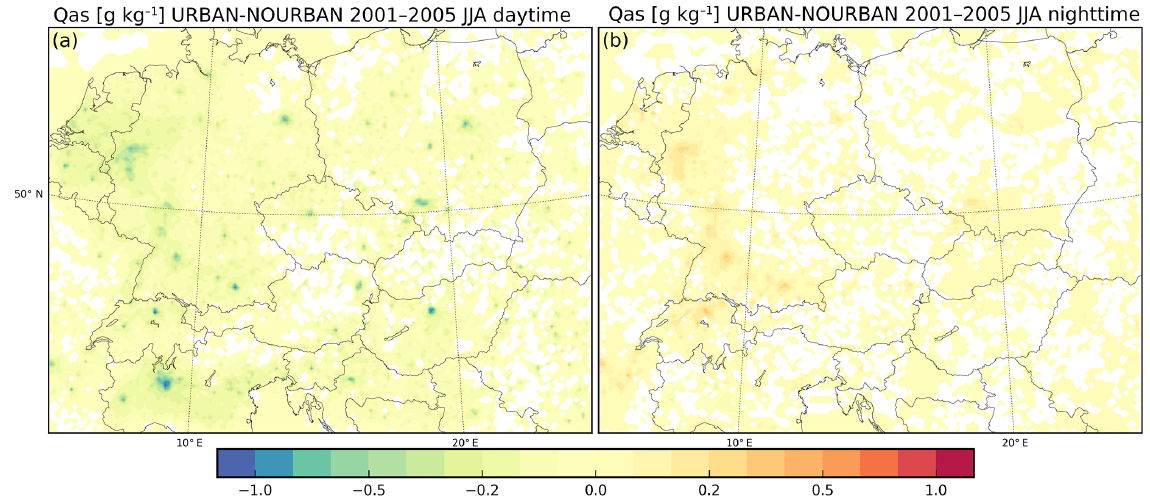
Figure 2. Impact of urban canopy on the near-surface absolute humidity for 2001–2005 JJA ingkg − 1 for daytime (a) and nighttime (b) . Shaded areas represent a statistically significant impact at the 98% level using the t